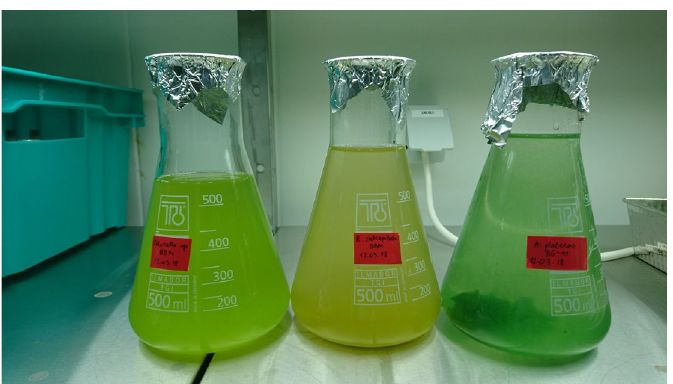
Figure 4. Example of algae species used in the experiment (personal collection). From the left: Chlorella sp, R. subcapitata, A.